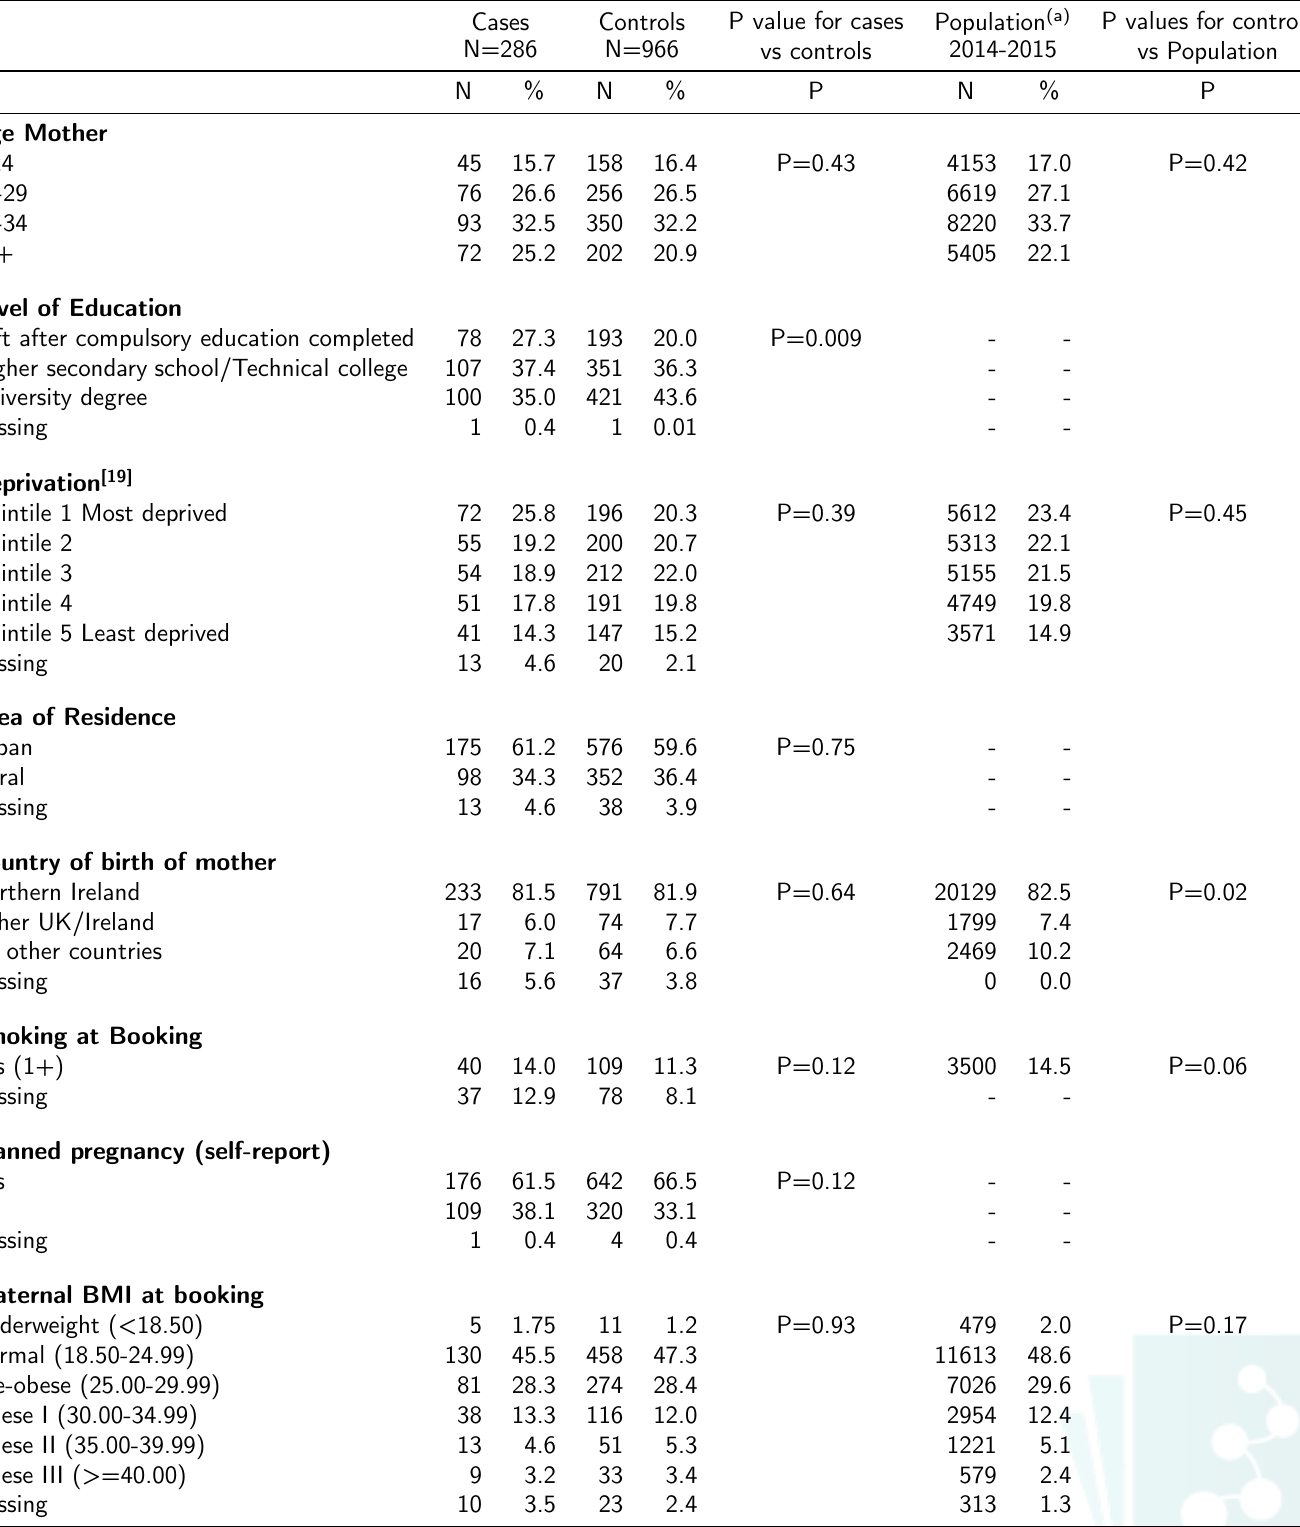
Table 1: Distribution of sample by key demographic variables, and comparison with population information where available.